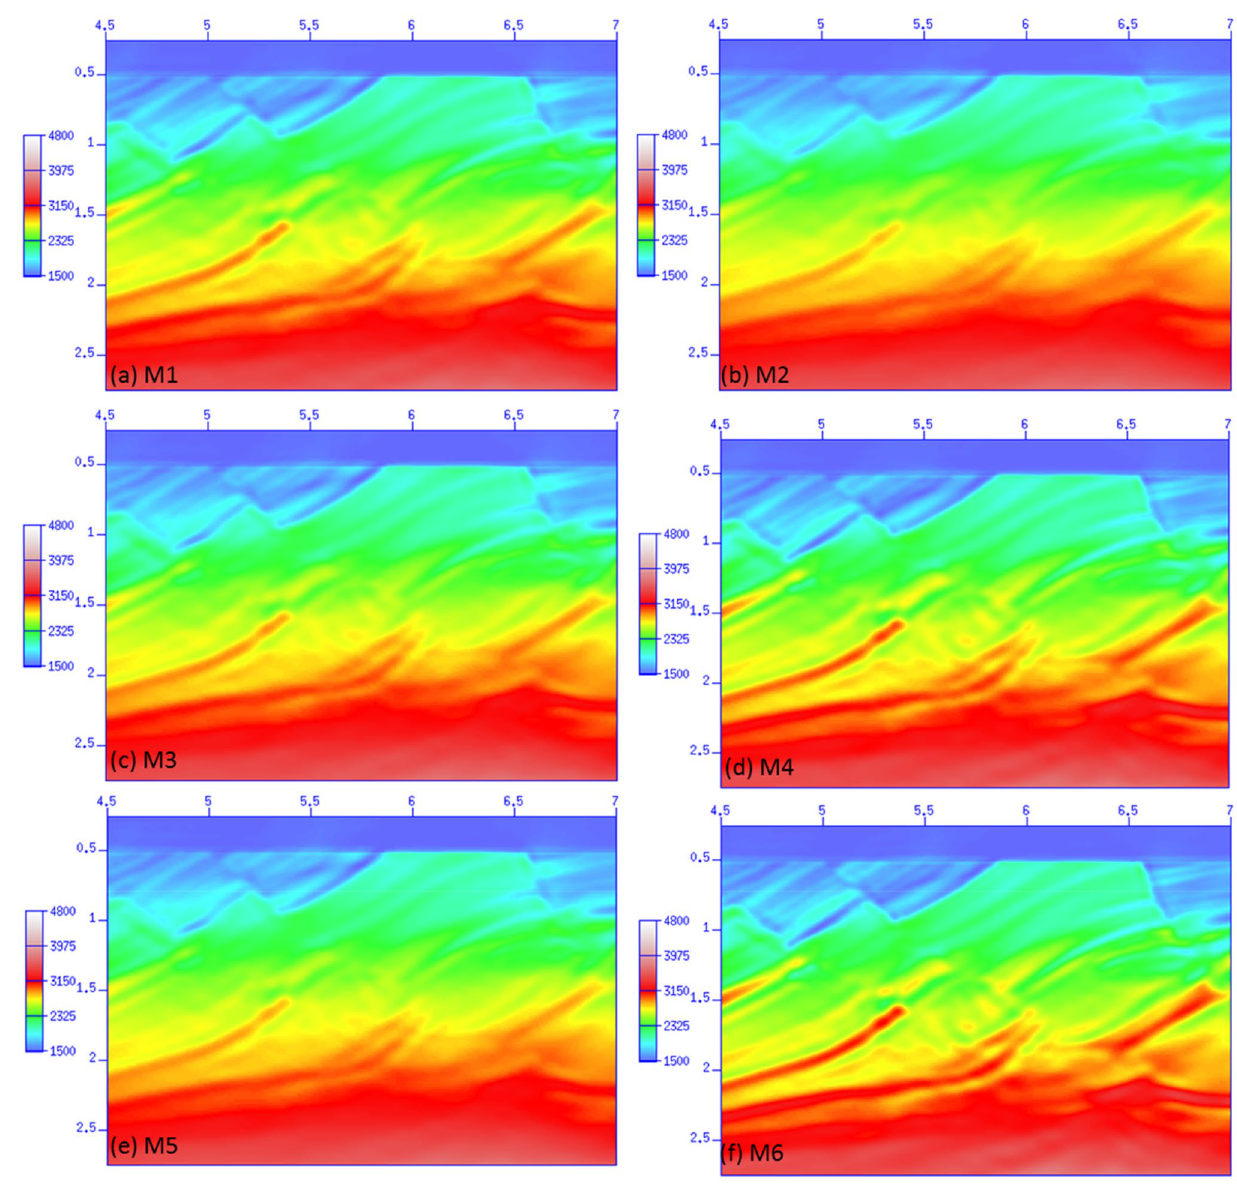
Fig. 5 Zoomed section of the inverted Marmousi Model with different methods; it can be observed that the output of the proposed method (M4, M5, M6) outperforms conventional a selective angle filtering b and Cosine (with power 3)